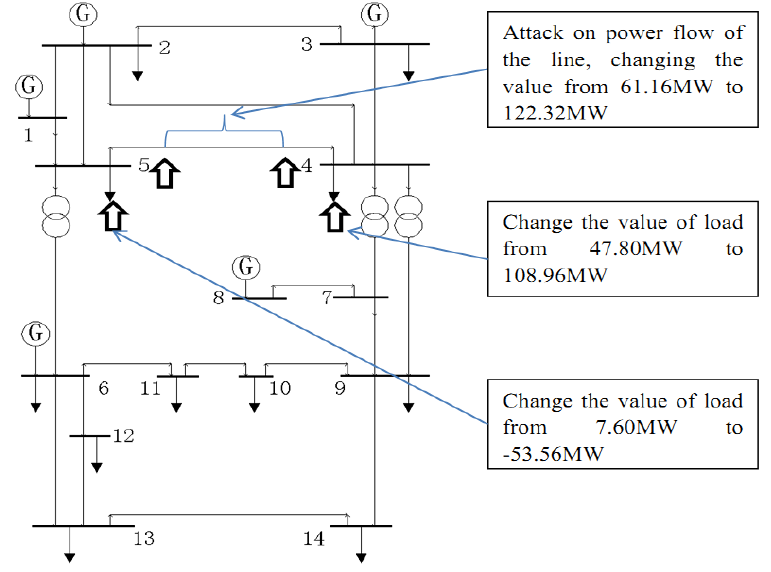
Figure 1. An attack case on IEEE 14-bus